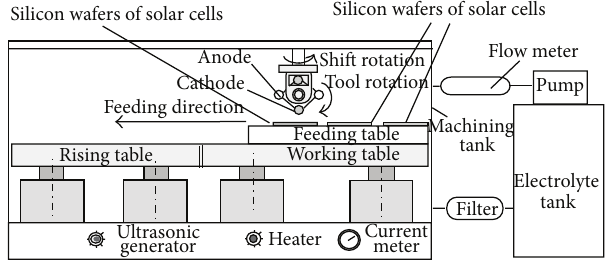
Figure 1: Experimental setup of recycling system for solar-cell silicon wafers.